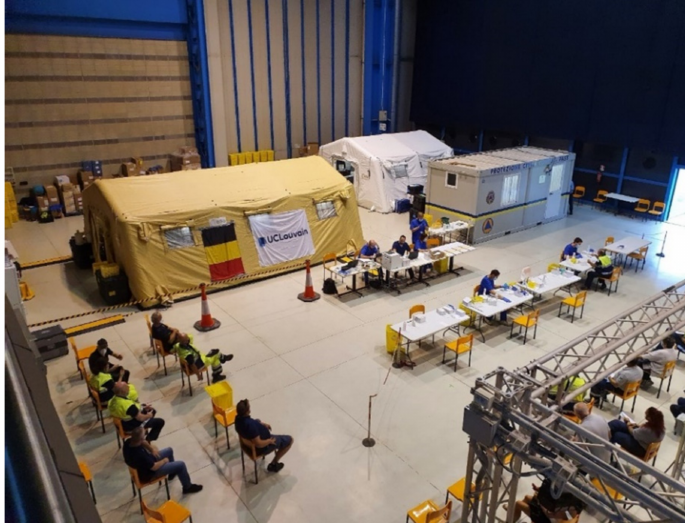
Figure 11. Overview of the B-LiFE deployed in Turin, Italy, from June to July, during the COVID-19 crisis.